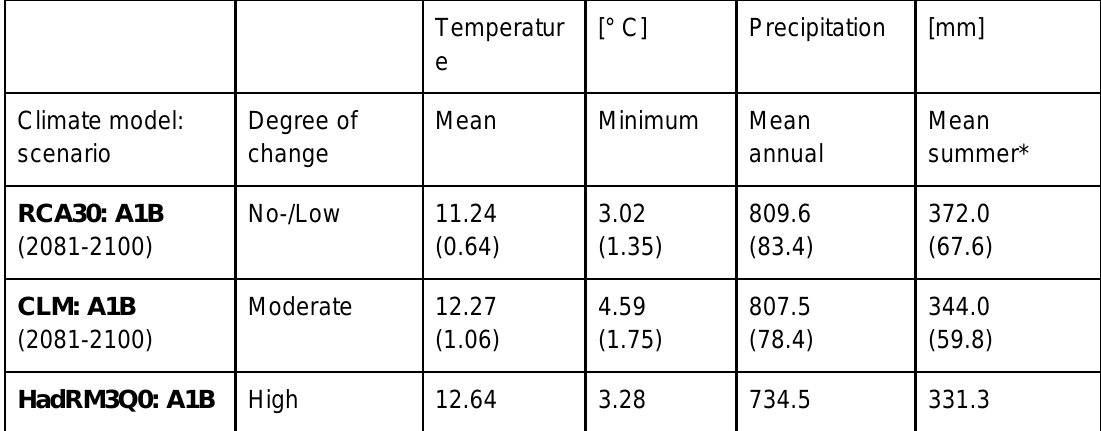
Table A1.2 An example of climate data produced by RCMs and used for further climate and forest interactions